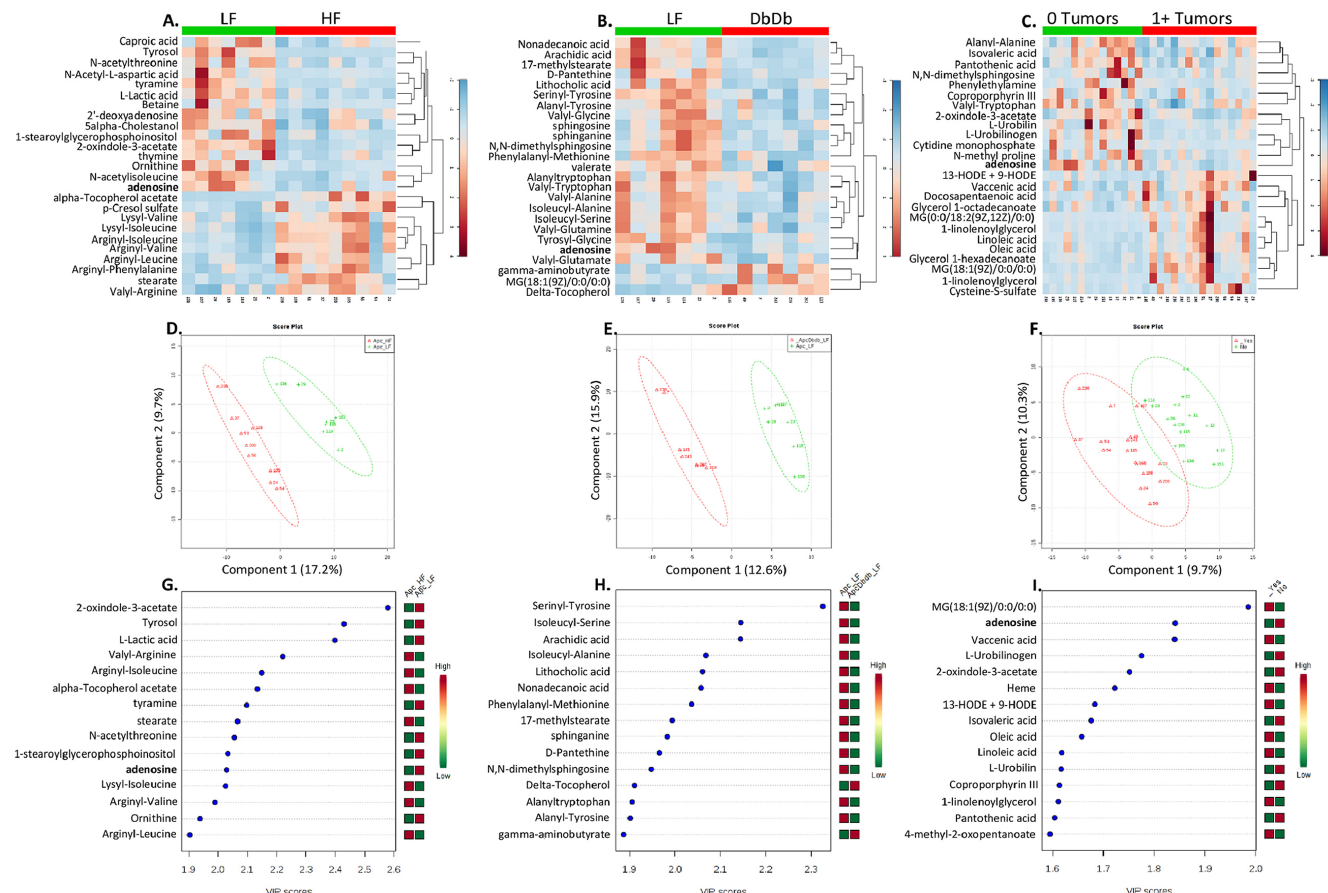
Fig 3. Impact of obesity and intestinal tumor presence on the fecal metabolome of mice. Low and high fat fed mice are compared in the first column (A, D,G). Low fat fed and genetically obese mice are compared in the second column (B,E,H). Mice with and without intestinal tumors are compared in the third column (C,F,I). The top row (A-C) shows heat maps of top 25 most significantly different metabolites for each comparison (p < 0.05); color represents normalized metabolite concentration from low (blue) to high (red). The second row (D-F) shows discrimination of groups using partial least squares discriminate analysis. The third row (G-I) shows the metabolites most strongly influencing discrimination by the partial least squares discriminate analysis. The Variable Importance In Projection (VIP) score is the weighted sum of squares for the partial least-squares loadings with the amount of variance explained by each component taken into